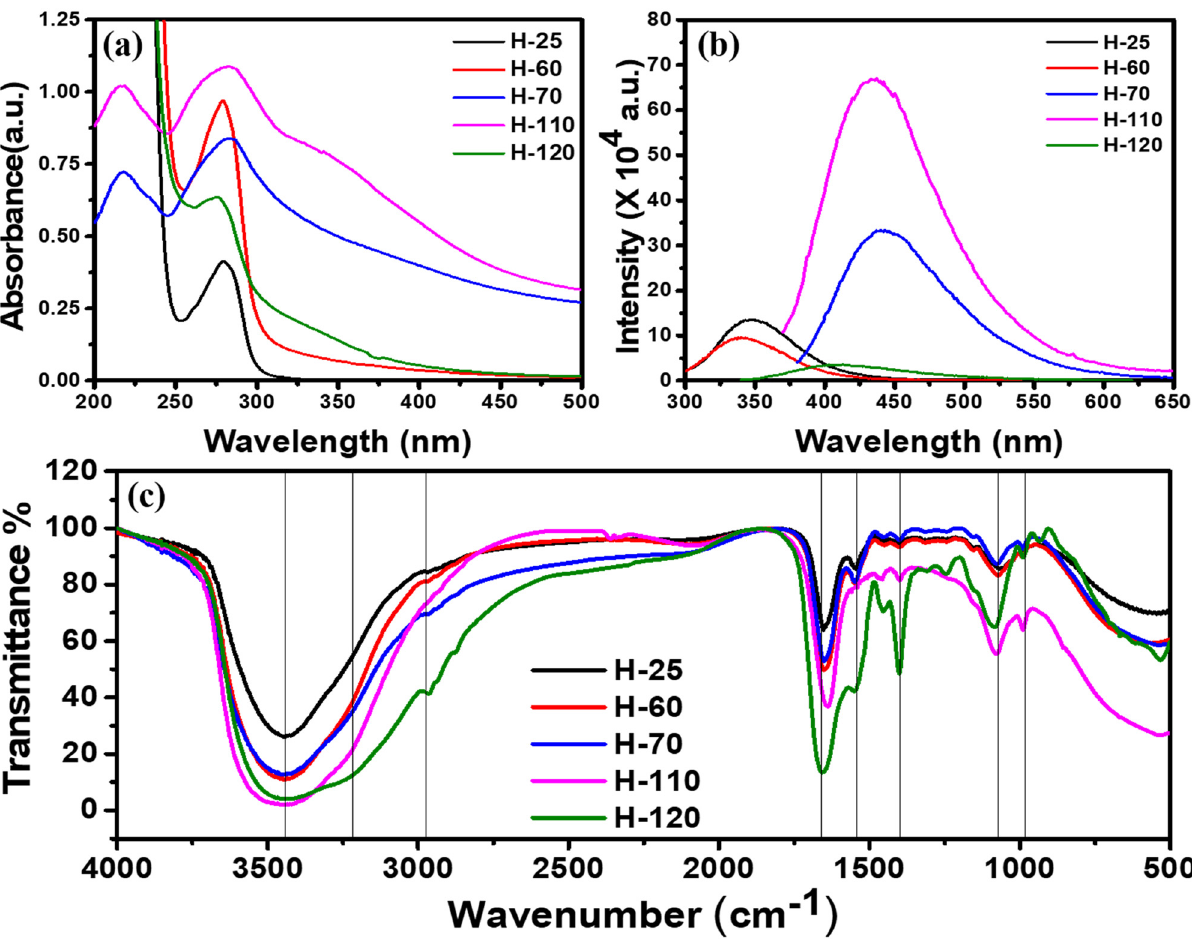
Figure 2: ( a ) UV - Vis spectrum of di ff erent phases of BSA protein; ( b ) PL spectrum of di ff erent phases of protein at their maximum excitation wavelength; ( c ) FTIR spectrum of di ff erent